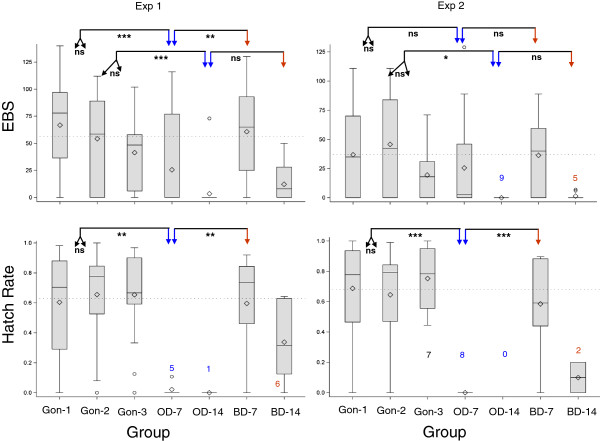
Variation in egg batch size (EBS) and hatch rate within and between treatment groups across the two experiments. Short-term (OD-7) and long-term (OD-14) oviposition-site deprived (OD) female groups are marked by the blue arrows and blood-deprived (BD) female groups are marked by red arrows. The dotted horizontal line denotes average across the first three gonotrophic cycles without deprivation. Sample sizes smaller than 10 are denoted by numbers with corresponding box-whisker plots. Analyses as described in Table
1 (EBS – 0 included and hatch rate), conducted on each experiment separately were used to compute the contrasts depicted by the arrows. In a box-whisker plot, lines and diamonds denote medians and means, respectively, ‘boxes’ mark quartiles, and ‘whiskers’ extend up to 1.5 times the inter-quartile range, while circles denote values beyond the whisker boundaries. Significance levels of ANOVA tests are denoted as: ns P>0.05; *P<0.05; **P<0.01; ***P<0.001.